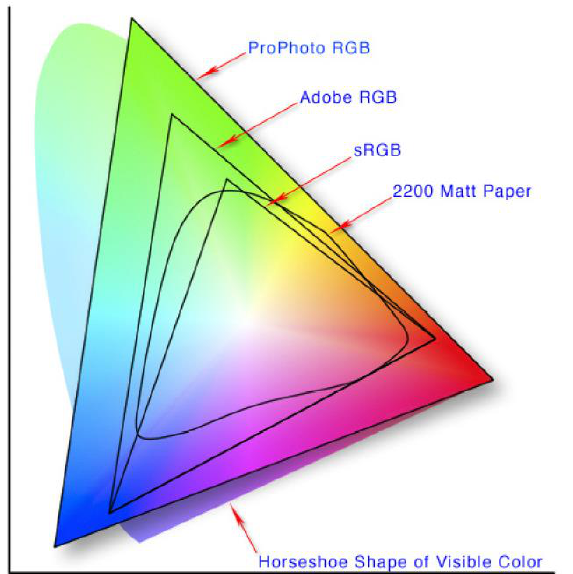
Figure 6. Colour spaces within the RGB colour model (Schewe, 2018)